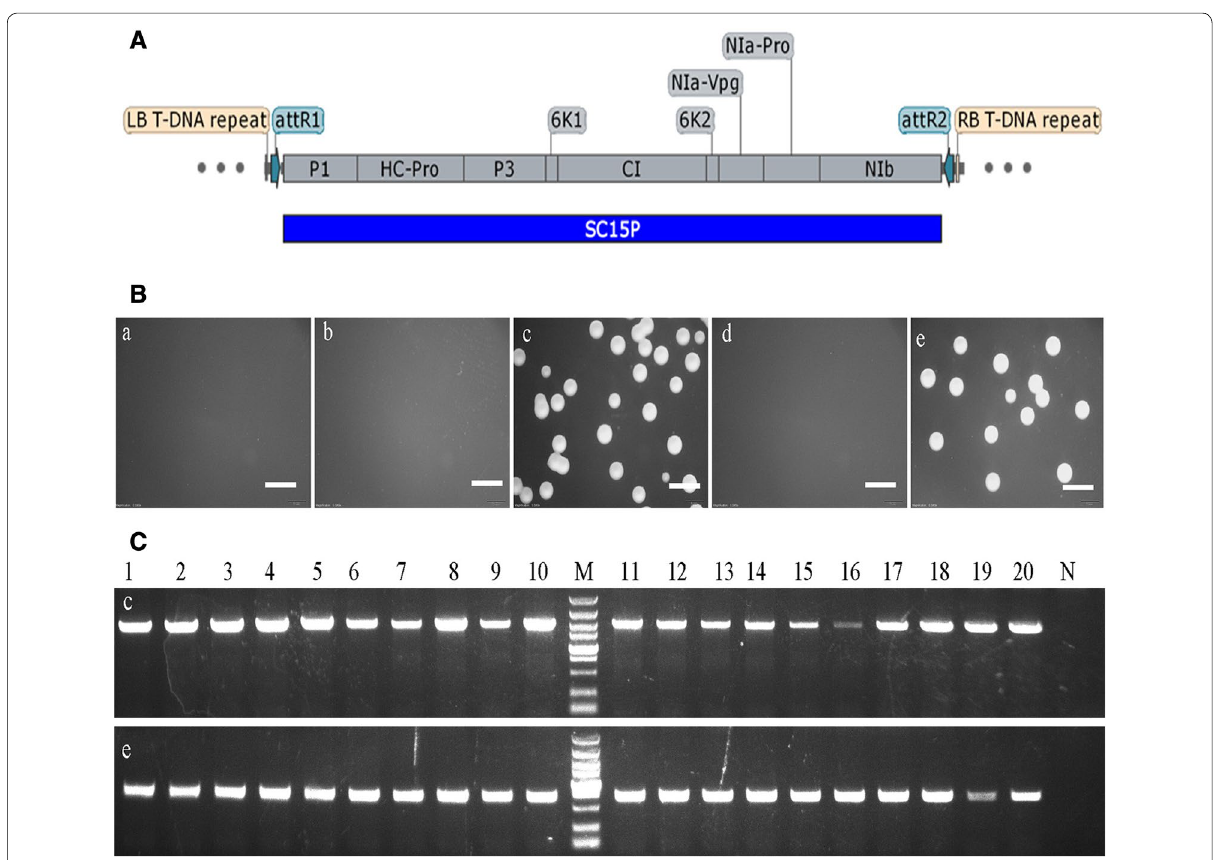
Fig. 5 Application of the Agrobacterium growth inhibition sequence in screening recombinant clones. A Structure of the destination vector pCB301- att L-SC15P, which shows the elements between LB and RB; B Growth of Agrobacterium at 2 days post-transformation with pCB301- att L-SC15P (a), pDonor-Zeocin-CI (b), pDonor-Zeocin-Avh241 (c), LR recombination reaction product between pCB301- att L-SC15P and pDonor-Zeocin-CI (d), LR recombination reaction product between pCB301- att L-SC15P and pDonor-Zeocin- Avh241 (e); scale bars Identification of the colonies by PCR: 1 to 20 of (c) and (e) represent the colonies picked from the (c) and (e) plate in the B panel; N represents the negative control that used ddH 2 O as its template; the DNA marker is